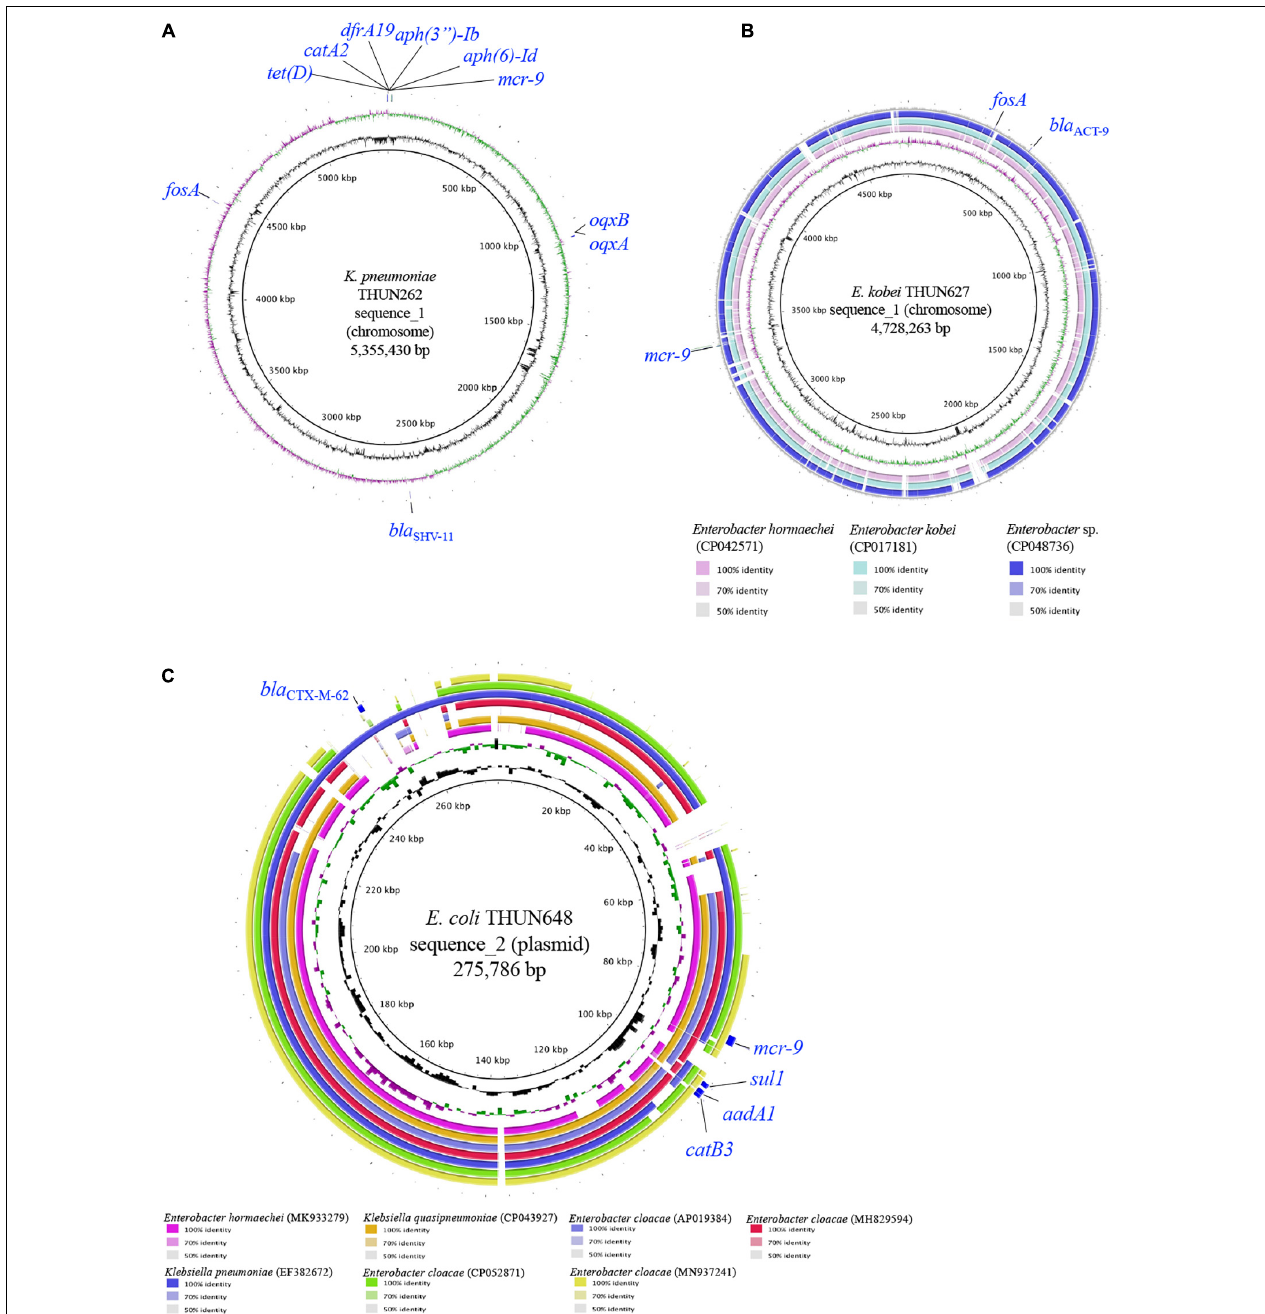
FIGURE 3 | Circular structure of chromosome harboring mcr-9 of K. pneumoniae THUN262 (A) , E. kobei THUN627 (B) , and plasmid harboring mcr-9 of E. coli THUN648 (C) . The green and purple circles indicate GC skew, and the black circles indicate GC